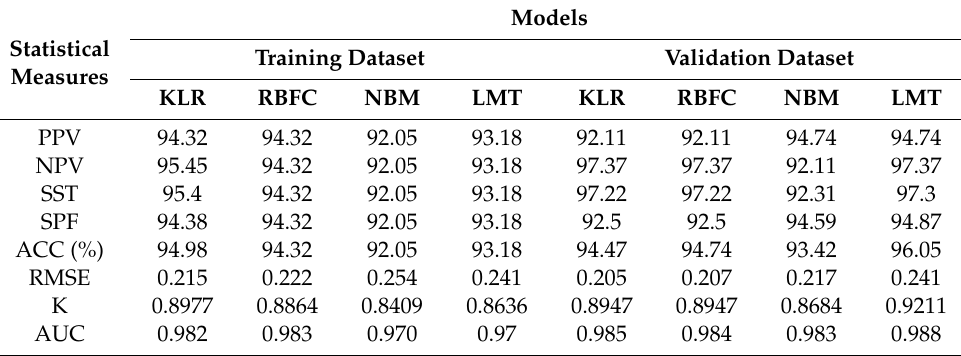
Figure 6. ROC analysis of the models: ( a ) training dataset; and ( b ) testing dataset. Table 1. Summary of validation results of the models.